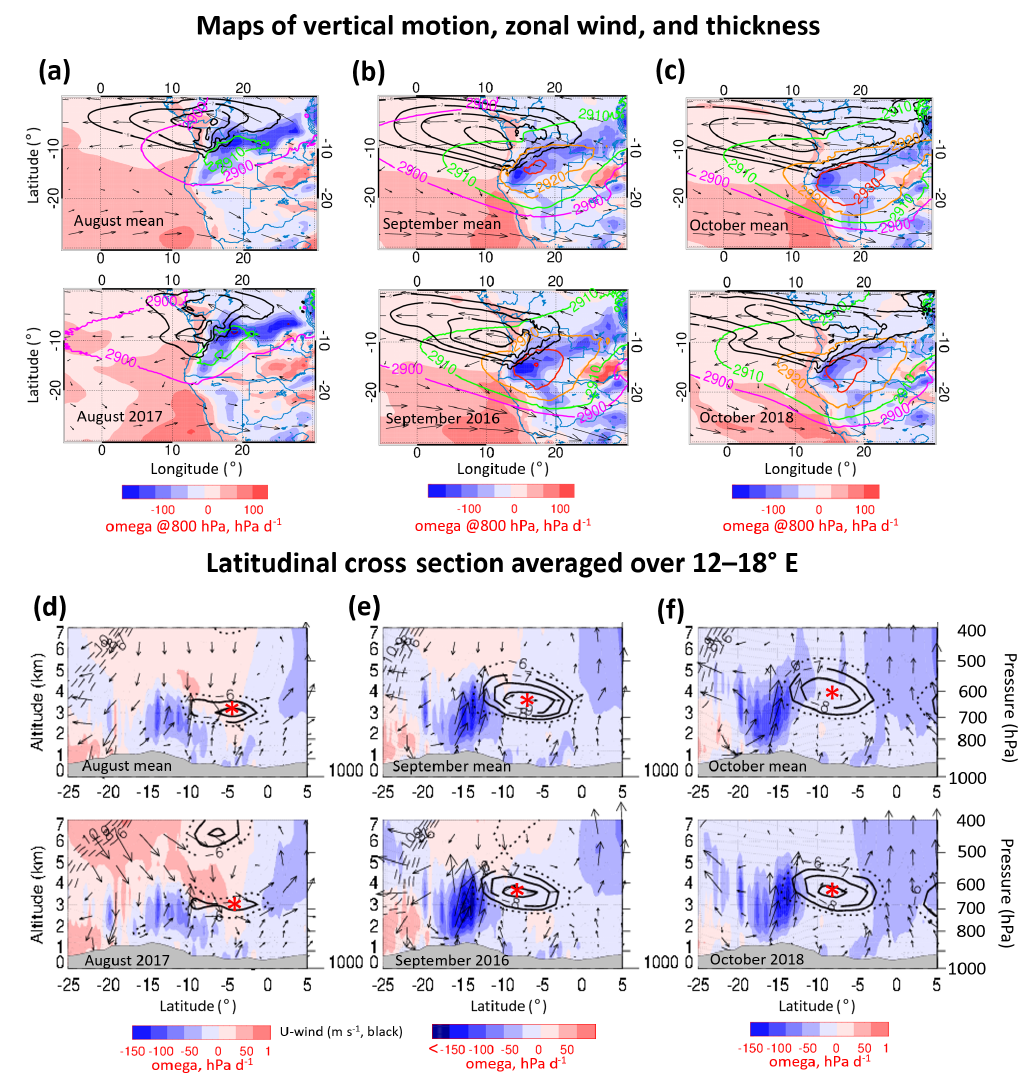
Figure 6. (a) Maps of 800hPa vertical velocity (omega; shading; hPad − 1 ; positive values refer to subsidence) overlain by thickness between 600 and 850hPa (color contour with 10m interval from 2900; meters), 700hPa zonal wind (black contour; ms − 1 ), and 700hPa horizontal wind (wind vector; ms − 1 ) in (a) August for (top) the climatological mean and (bottom) the deployment month. (b, c) The same as August except for 600hPa in September and October. (d–f) Latitudinal cross sections of vertical velocity (omega ( ω ); shading; hPad − 1 ) averaged over 12–18 ◦ E overlain by wind vector (vector, meridional wind, and − 1 · omega ( v ; ω ); ms − 1 ; for positive value to represent the ascent) and zonal wind (black contour; ms − 1 ) for (top) the climatological mean and (bottom) the deployment month. The gray-filled area represents the inland topography. The red asterisk in panels (d) – (f) represents the AEJ-S